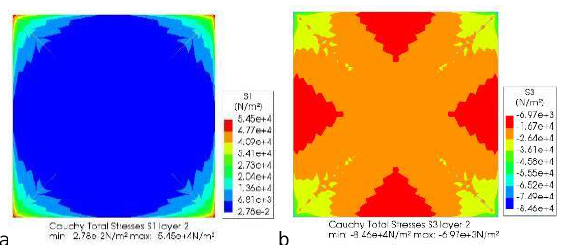
Figure 14. The principal total stress results of linear analysis on the medium surface of the second model with rolled constraints: a. Tensile. b. Compression.